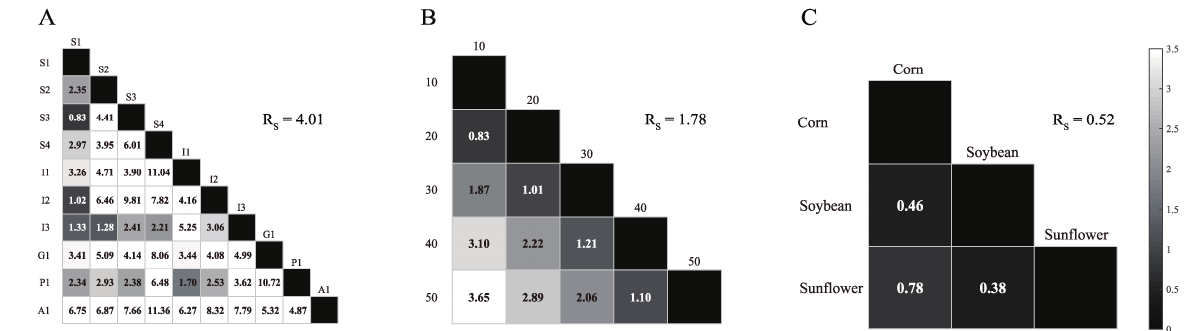
Figure 4. ANOVA-PDR mapping of the three main factors. ( A ) EVOO Origin; ( B ) Adulteration Level; ( C ) Adulteration Type. R s , geometric average of all PDR scores.